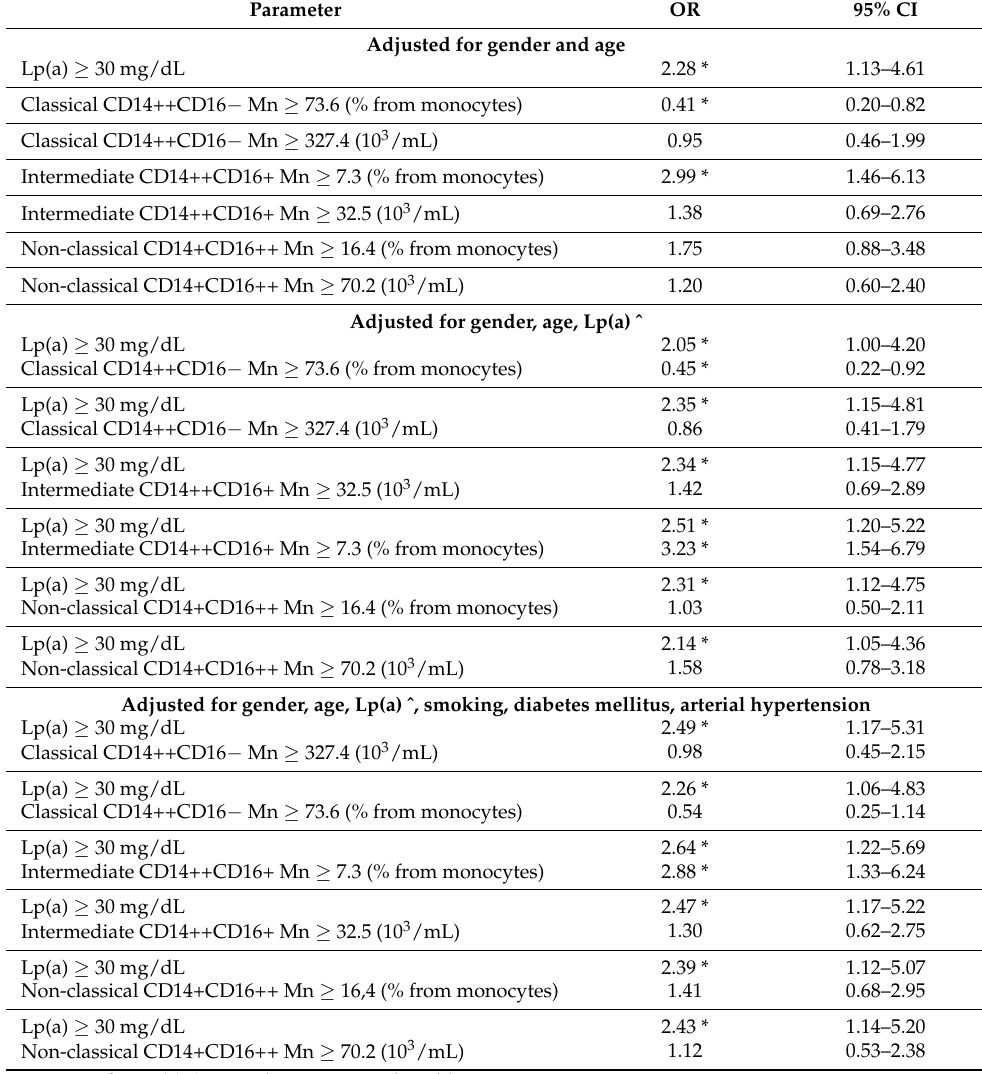
Table 3. HyperLp(a) and the monocyte subsets in association with triple-vessel coronary